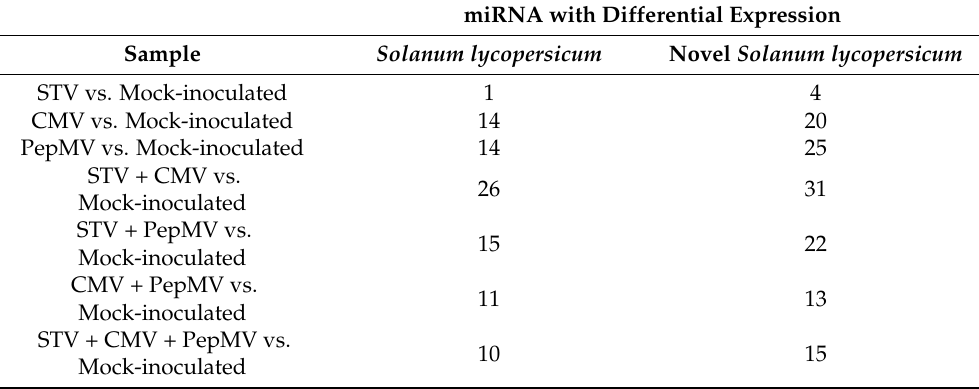
Table 1. Differential accumulation of miRNAs in tomato plants infected with different virus combi- nations with respect to the control mock-inoculated plants (FDR < 0.05 and log2FC > 0.56). miRNA with Differential Expression Sample Solanum lycopersicum Novel Solanum lycopersicum STV vs. Mock-inoculated 1 4 CMV vs. Mock-inoculated 14 20 PepMV vs. Mock-inoculated 14 25 STV + CMV vs. 26 31 Mock-inoculated STV + PepMV vs. Mock-inoculated Mock-inoculated